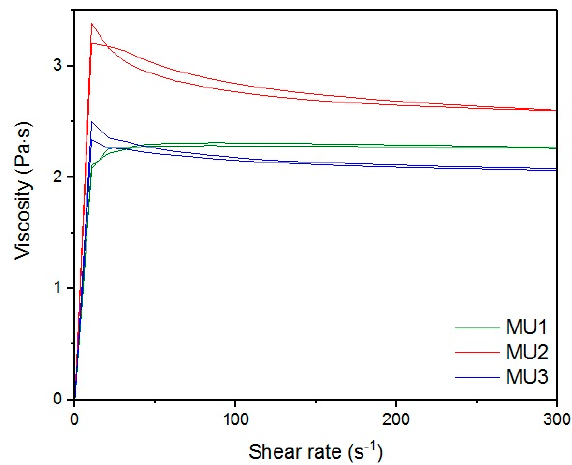
Figure 17. Magnification of the viscosity-shear rate relations for MU1 and MU3 prepolymers at CSR = 300 s − 1 .